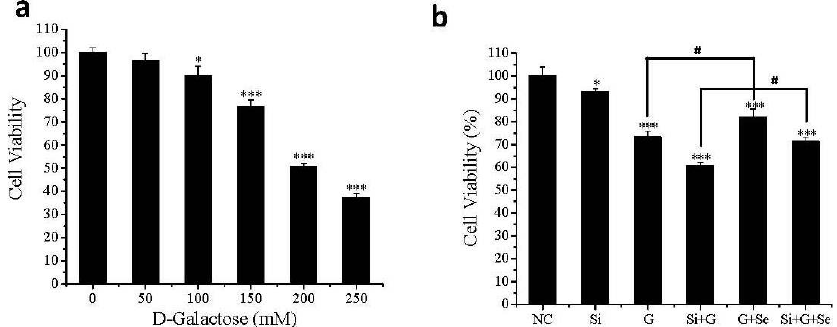
Effect of SelR gene knockdown and Na 2 SeO 3 on D -galactose-induced cell death. ( a ) The viability of hLE cells after treatment with the indicated concentrations of D -galactose; ( b ) The viability of hLE cells in the indicated groups. Data are the mean ˘ SD of at least three independent experiments. * p < 0.05, *** p < 0.001, compared to the negative control group; # p < 0.05. NC: negative control cells; Si: cells with SelR siRNA transfection for 24 h; G: cells exposed to D -galactose (150 mM) for 36 h; Si+G: cells with SelR siRNA transfection followed by D -galactose exposure; G+Se: cells exposed to galactose (150 mM) and Na 2 SeO 3 (1 µ M) for 36 h; Si+G+Se: cells with SelR siRNA transfection followed by galactose and Na 2 SeO 3